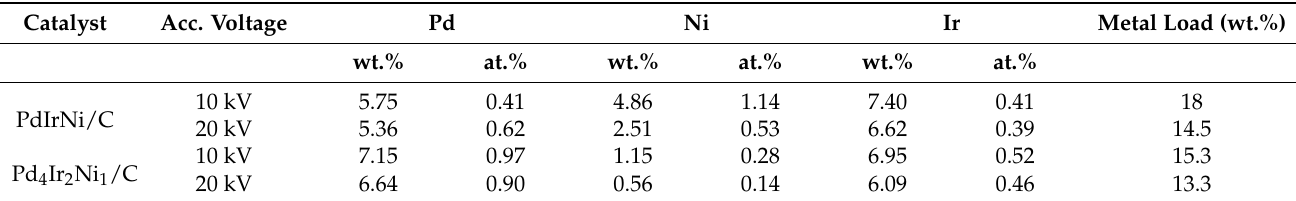
Table 3. Elemental energy-dispersive X-ray spectroscopy (EDX) compositional analysis and metal loading (wt.%) of the PdIrNi/C and Pd 4 Ir 2 Ni 1 /C surfaces.